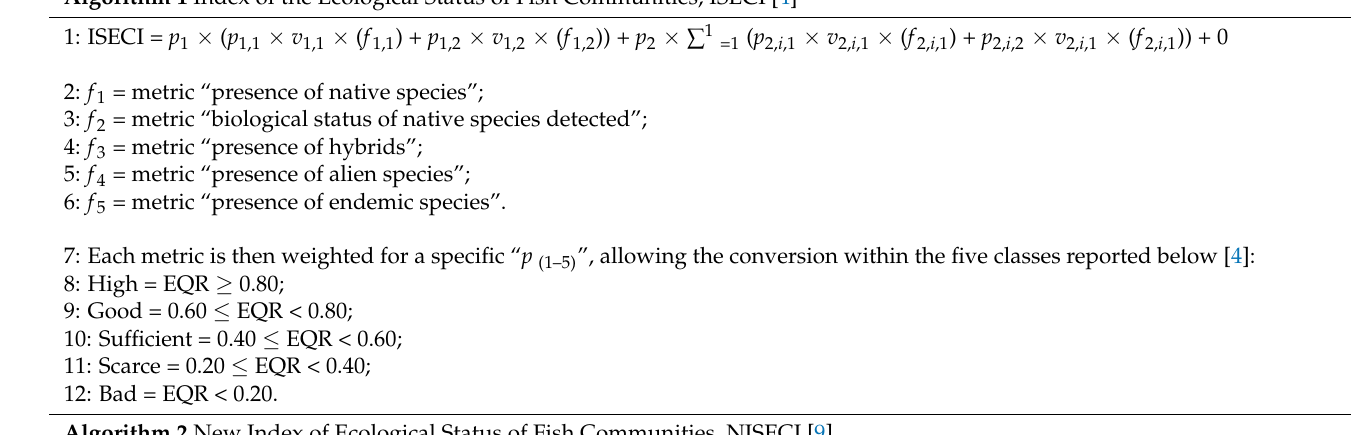
Algorithm 2 New Index of Ecological Status of Fish Communities, NISECI